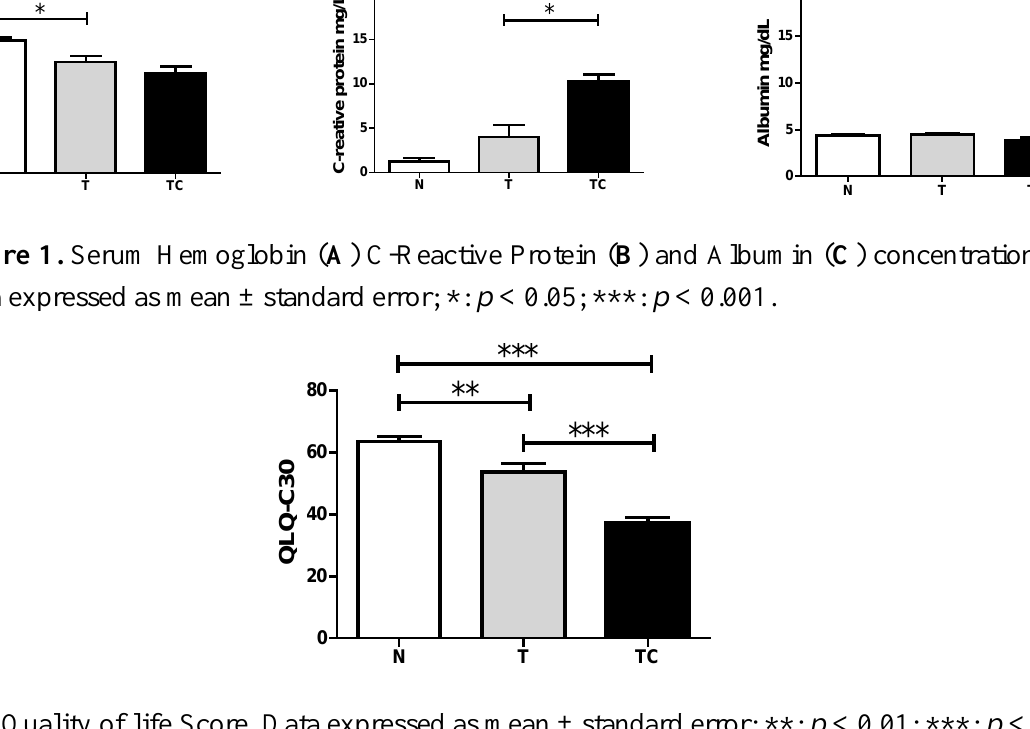
Figure 2. Quality of life Score. Data expressed as mean ± standard error; **: p < 0.01; ***: p < 0.001.